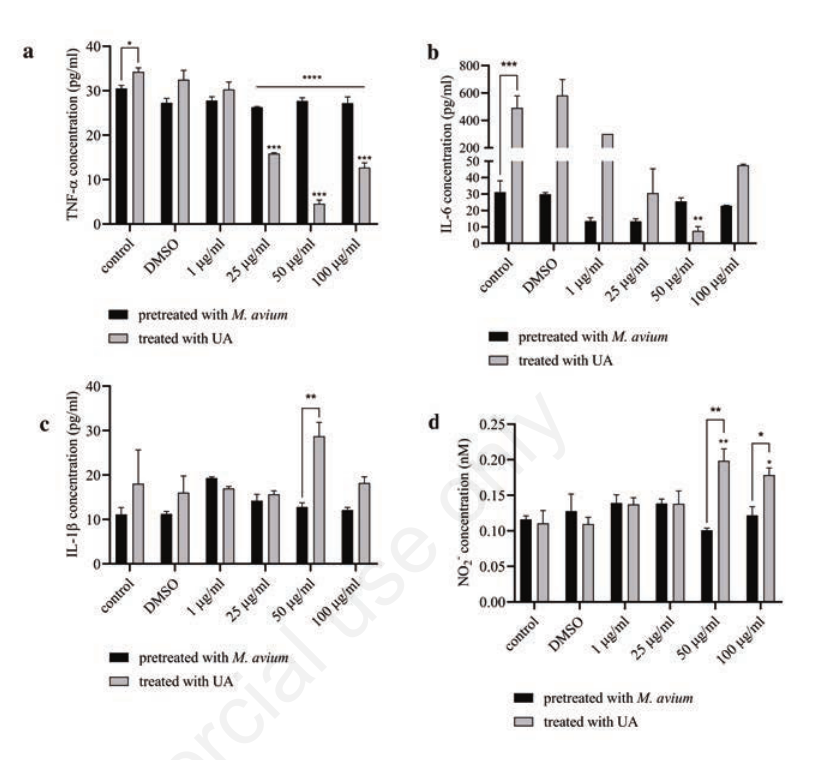
Figure 3. The concentrations of TNF-